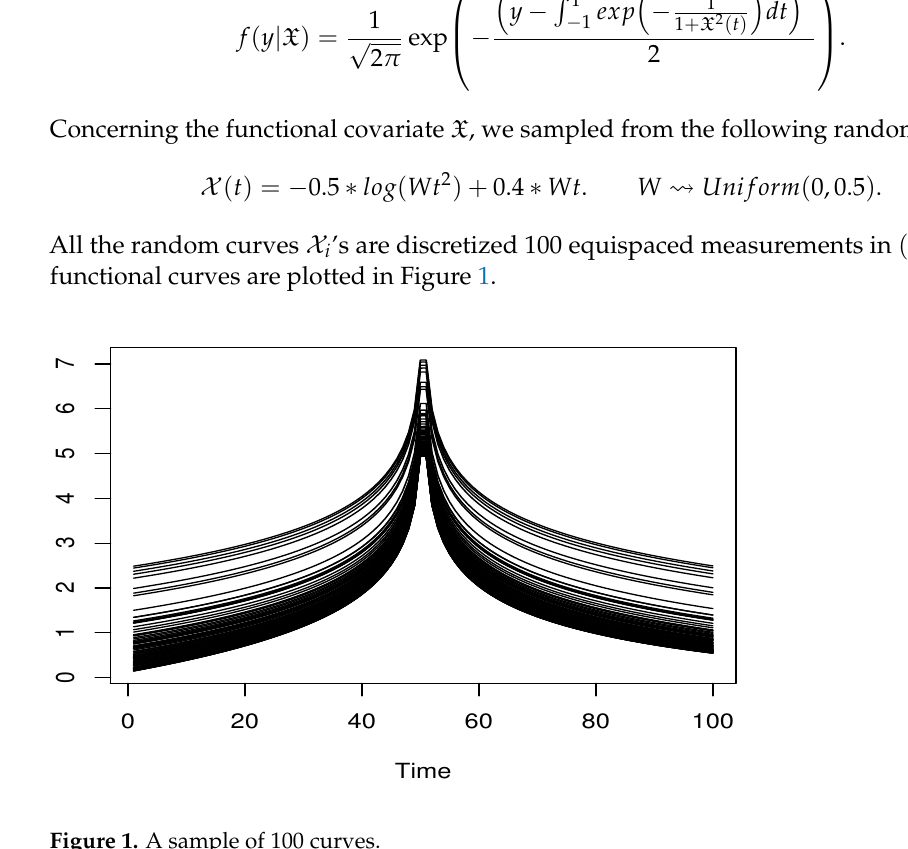
Figure 1. A sample of 100 curves.